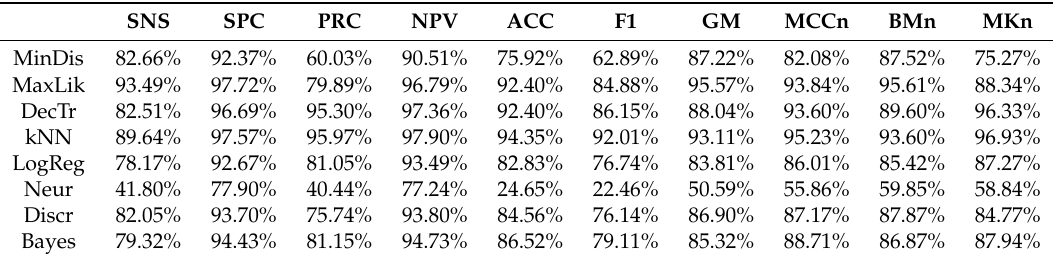
Figure 12. Boxplot of the performance metrics for the procedure of counting frames.